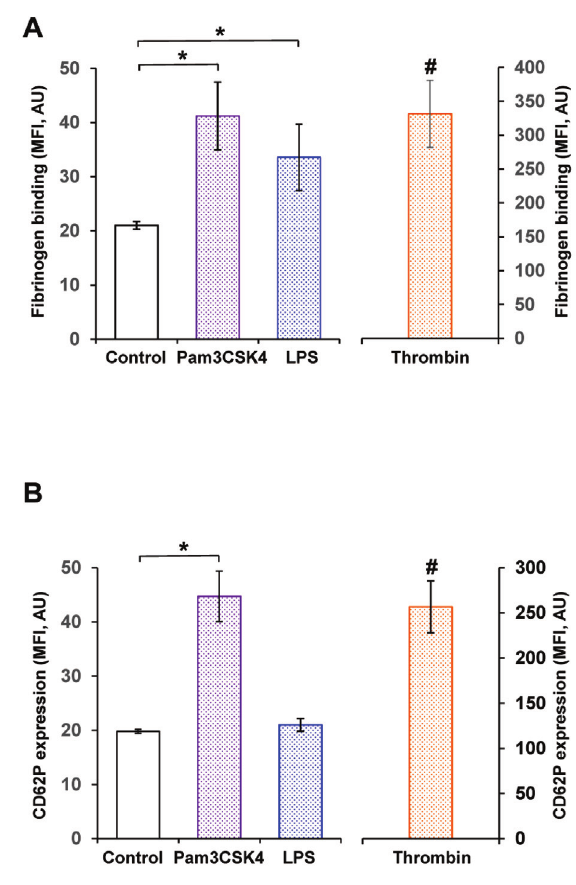
Fig.3 TLR2stimulationresultsinweakplatelet activation. Fibrinogen binding (A) and CD62P expression (B) were measured in WP after stimulation with15 µg/mLof Pam3CSK4 (purple column), 15µg/mLof LPS (blue column) or 0.5 U/mL thrombin (orange column) for 5minutes. Data are presented as mean MFI (cid:3) SEM; n ¼ 7; (cid:4) p < 0.05; compared with control. # < 0.05; compared with control, Pam3CSK4- or LPS-stimulated samples. LPS, lipopolysaccharides; SEM, standard error of mean; TLR, toll-like receptor; WP, washed platelets.